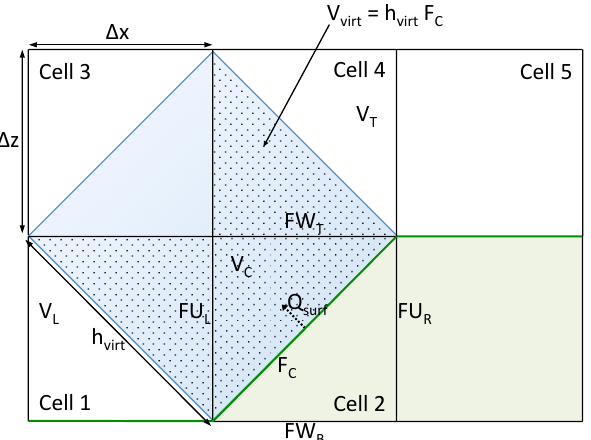
Figure 5. Example configuration for surface flux distribution around a cut cell. Green shading represents the solid part of the cells, whereas blue shading is the “virtual volume” normal to the cut cell face. The total surface flux Q surf is distributed within the dotted area.